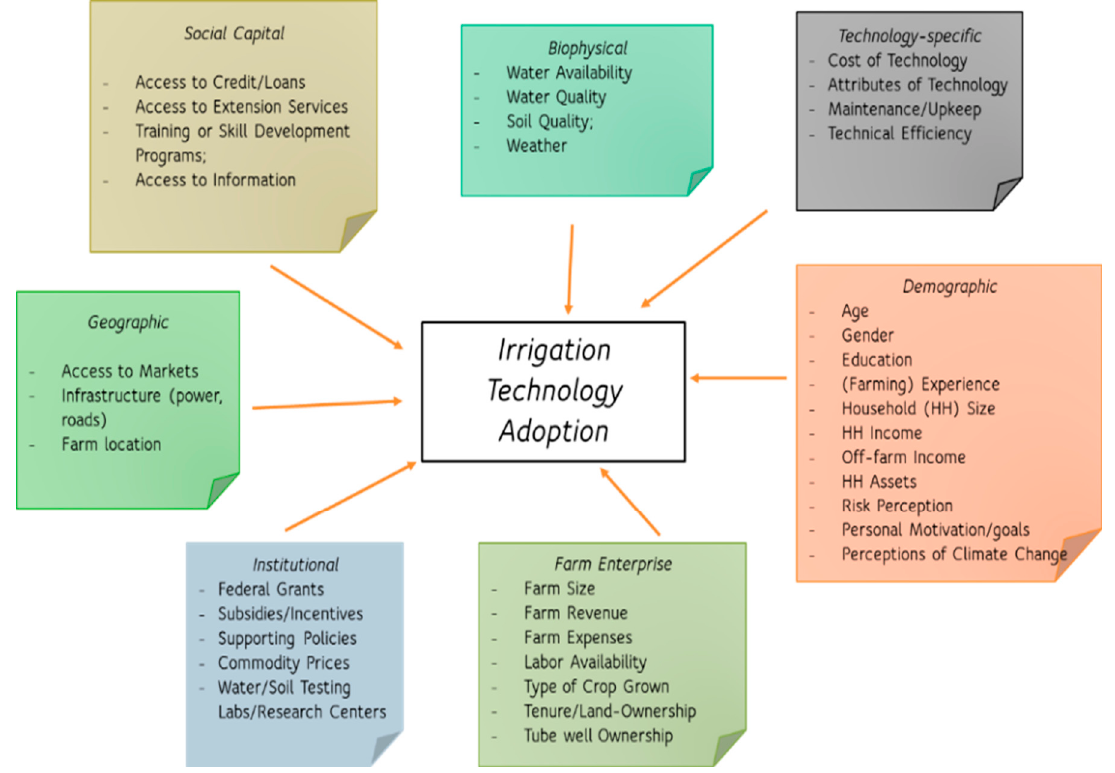
Figure 7. Categorization of different factors influencing farmers’ irrigation adoption decision-making.